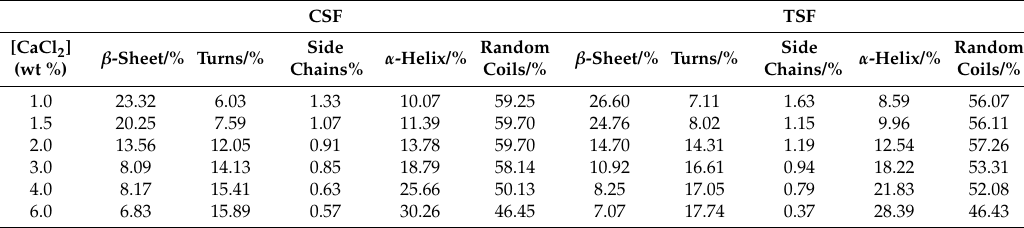
Table 6. Percentage of secondary structures in CSF and TSF samples obtained by FTIR structural analysis